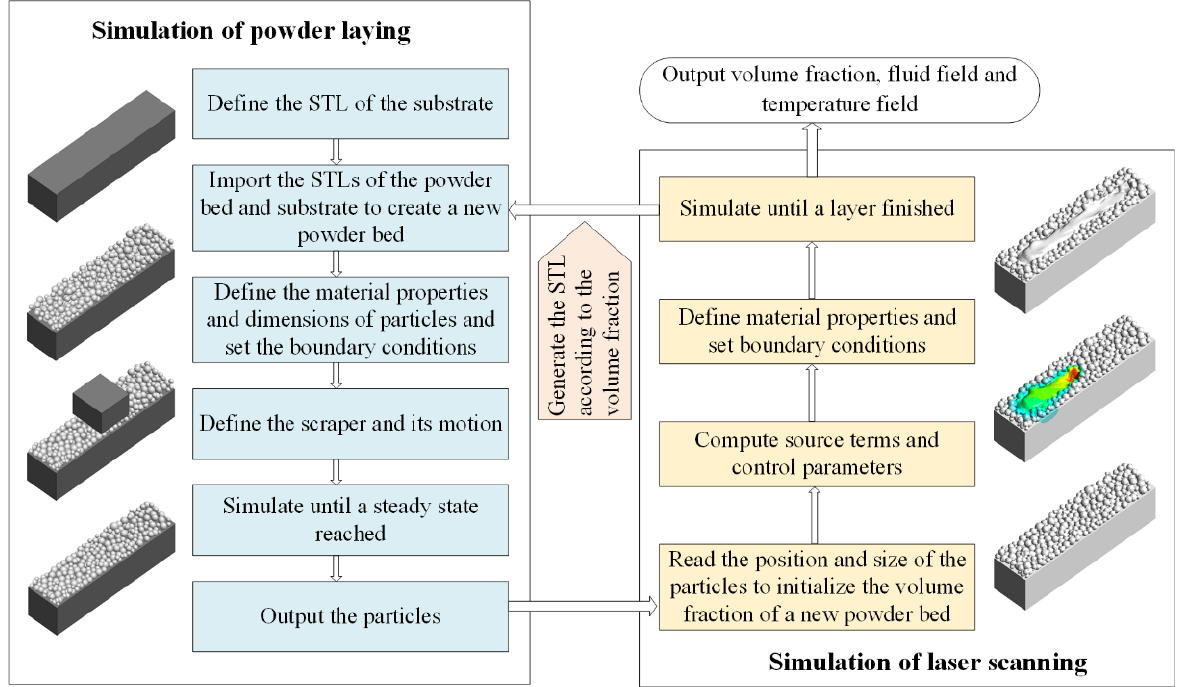
Figure 1. The flowchart for the simulation of SLM process.